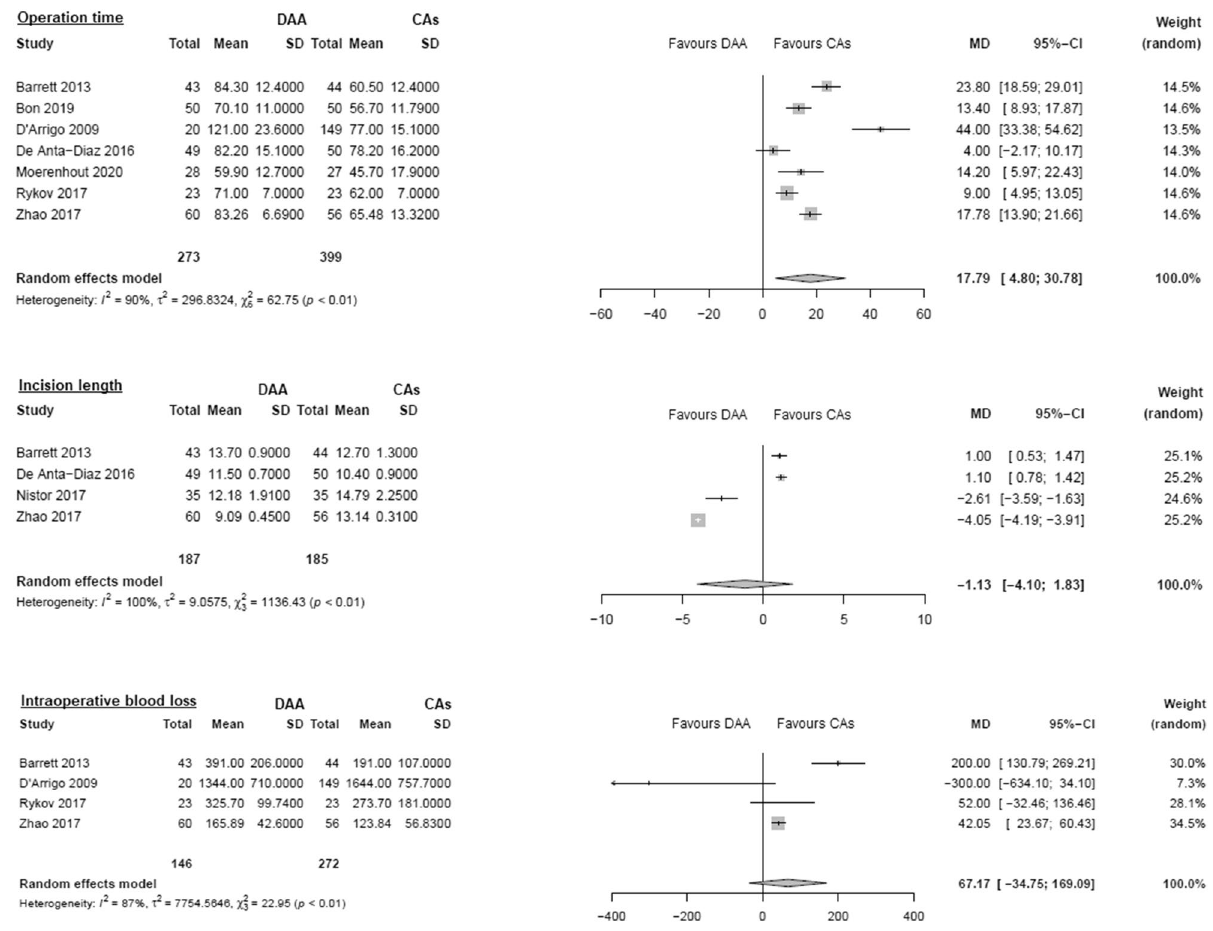
Figure 2. Comparison of the operation time, incision length, intraoperative blood loss. DAA direct anterior approach, CAs conventional approaches, SD standard deviation, MD mean difference, CI confidence